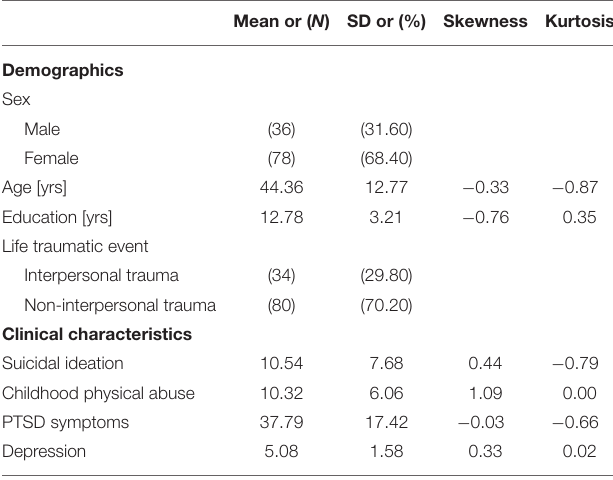
TABLE 1 | Demographics and clinical characteristics of patients with PTSD ( N = 114). Mean or ( N ) SD or (%) Skewness